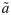
Characteristics of signal and bead coverage vs. bead size.(a) The normalized sensor signal and statistical standard deviation for the maximum surface coverage (solid and dashed red lines) and for a single bead (solid and dashed green lines) along with a sensor noise level chosen to V
noise/(GχH
ext) = 3 ⋅ 10−4 (blue line). (b) Values of ϕ
max (red line), ϕ
1 (green line), ϕ
stat (orange line) and ϕ
noise (blue line). The calculations were performed for square sensors (ℓ = 1), the indicated values of a˜, and h˜=0.05.